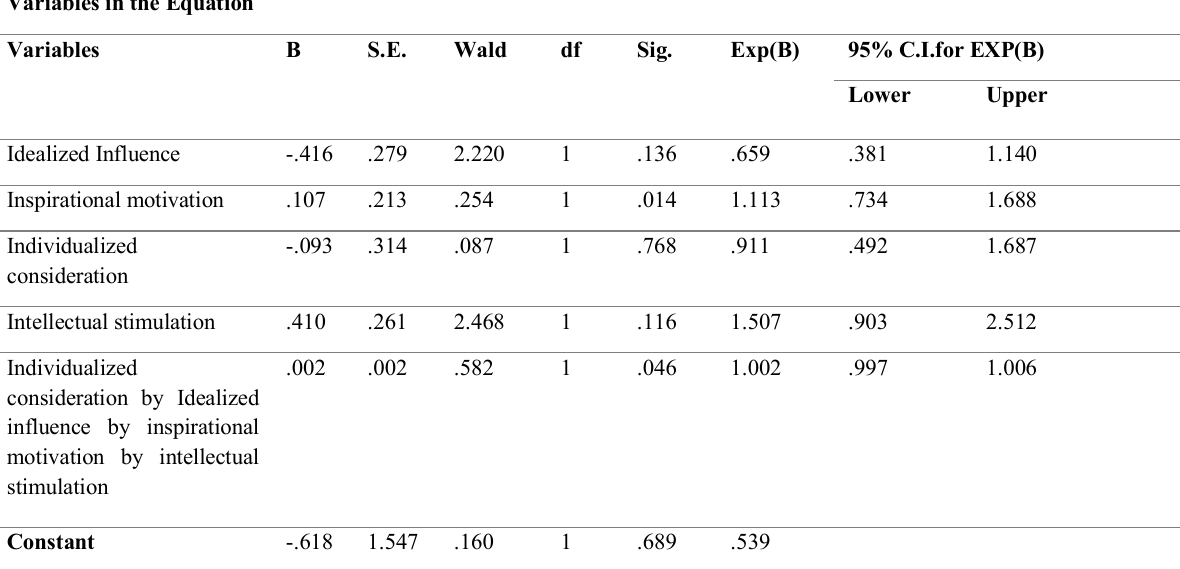
Table 8: PC m-health applications adoption and moderating role of transformational leadership style of hospitals’ management boards in Kenya.